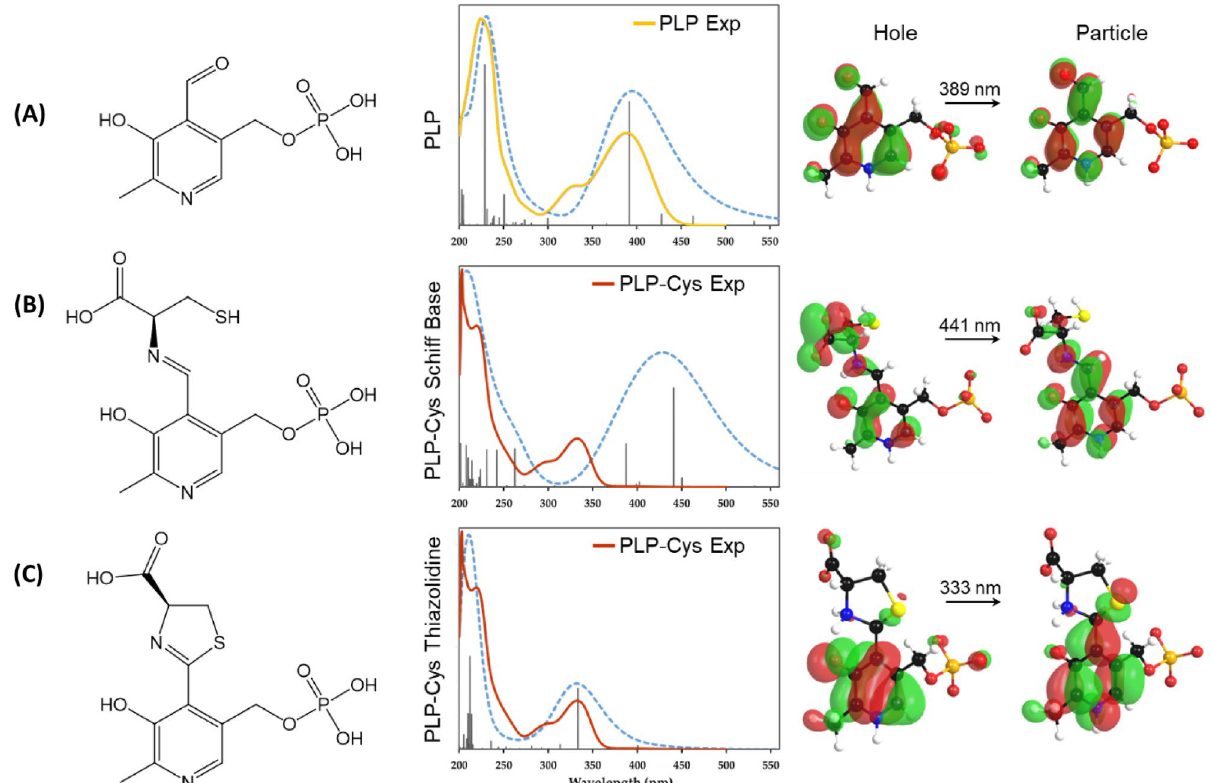
Figure 3. Comparison of experimental (solid lines) and calculated (dashed blue lines) absorption spectra for (A) PLP, (B) PLP-cysteine Schiff base, and (C) PLP-cysteine thiazolidine ring structures. The left side of each panel shows the molecular structure and the right side of each panel shows the natural transition orbitals at the peak of interest. The experimental spectrum of PLP matches well with calculated spectrum. The experimental spectrum of PLP-cysteine reaction after 2 h in PBS matches with formation of thiazolidine structure and not with Schiff